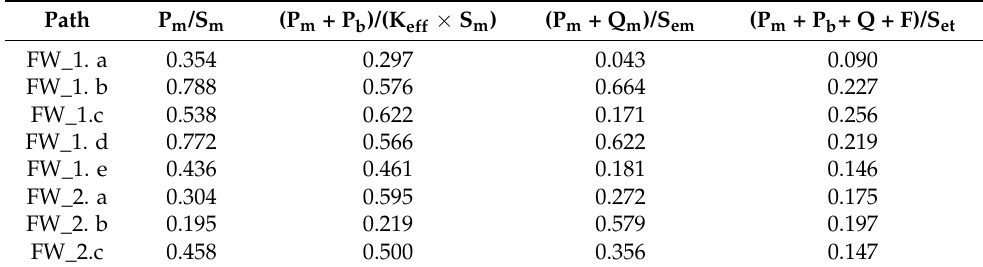
Table 5. RCC-MRx Level D criteria verification within FW-SWs domain.